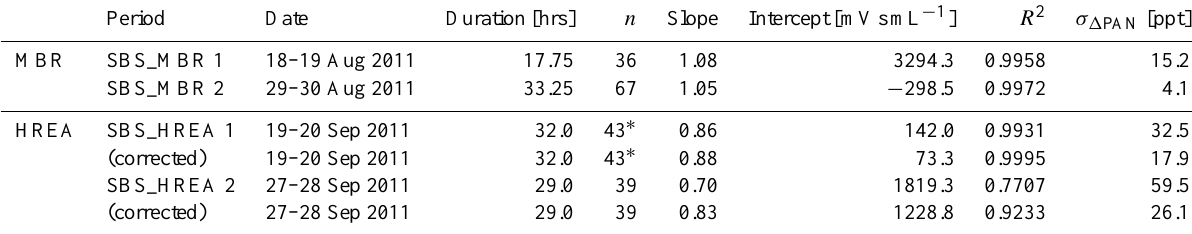
Table 1. Results from the side-by-side measurements during MBR and HREA operation, showing the parameters of the orthogonal fit functions. The residuals of the regression were used to determine the random error of the PAN mixing ratio differences ( σ 1 PAN ) .